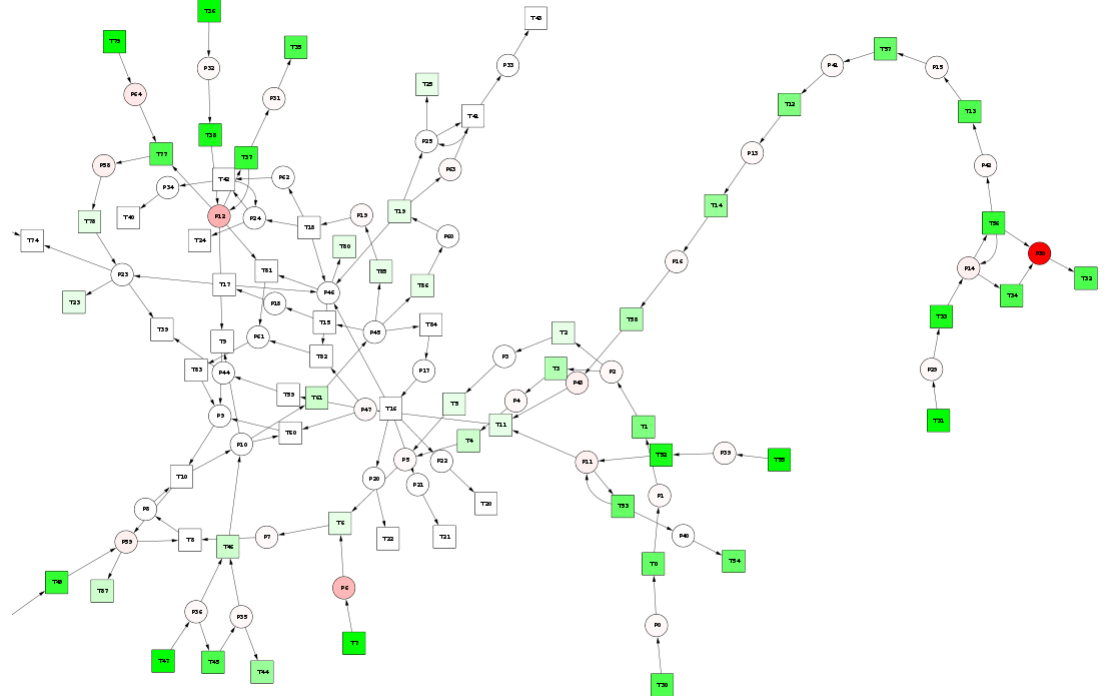
Figure 1: Screen shot of PetriScape plugin after simulating ten steps of the gene regulatory net- work modeling Duchenne muscular distrophy (previously used by Grunwald et al. , taken from Biomodels Database ID: 1403120000. Transitions were colorized in a green range according to the times that they were fired. Places were colorized in red in accordance to their relative token